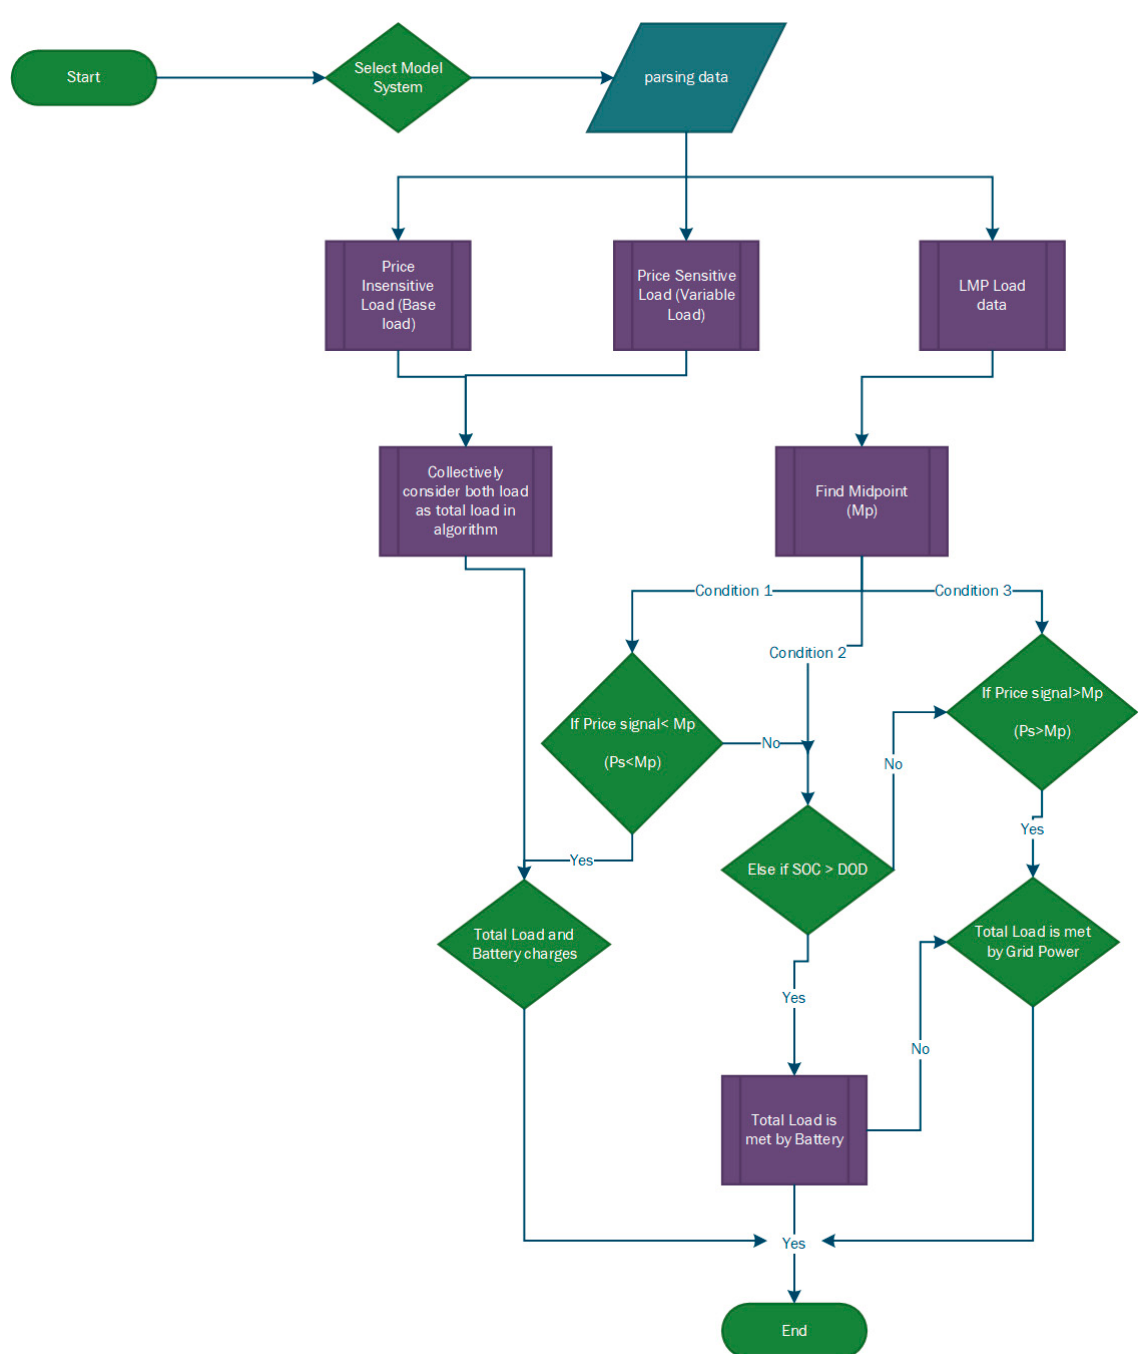
Figure 1. Flow chart of proposed algorithm based on the coordinated model of DR and BESS.